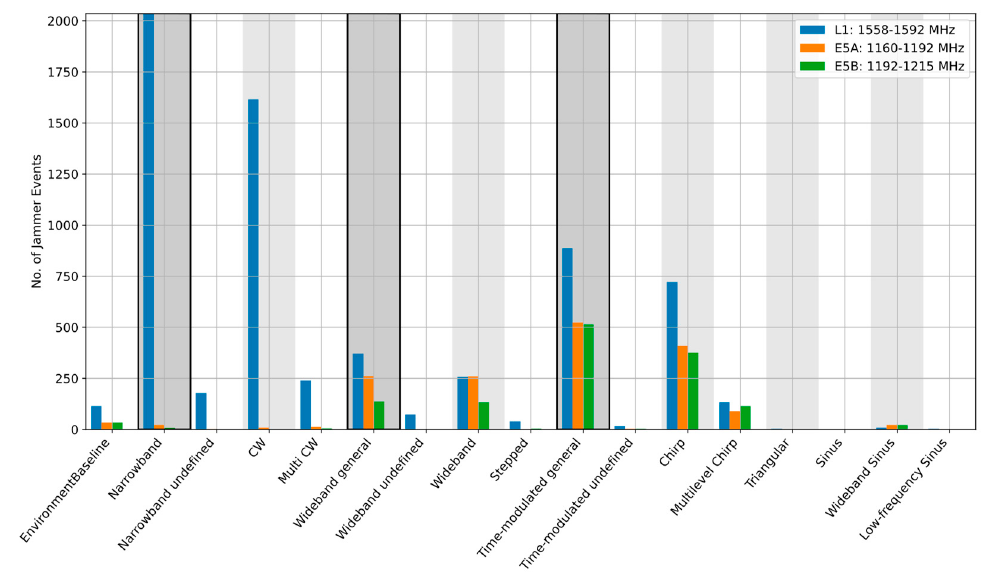
Figure 5. Detailed classification results, Moss station, Norway, 2021.